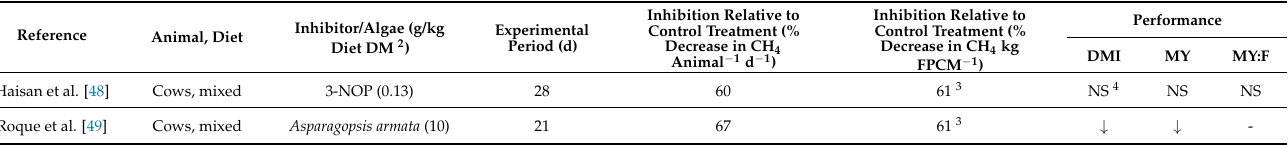
Table 3. In vivo milk production experimental treatments resulting in 60% or greater decrease in enteric methane (CH 4 ) production 1 .